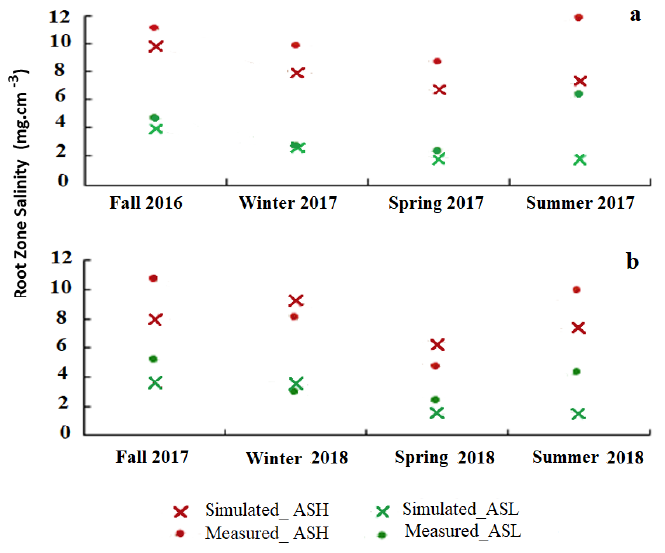
Figure 10. Seasonal (fall, winter, spring, and summer) simulated and measured root zone salinities at the low and high saline ASL and ASH sites, respectively, during the wet year 2017 ( a ) and the dry year 2018 ( b ).